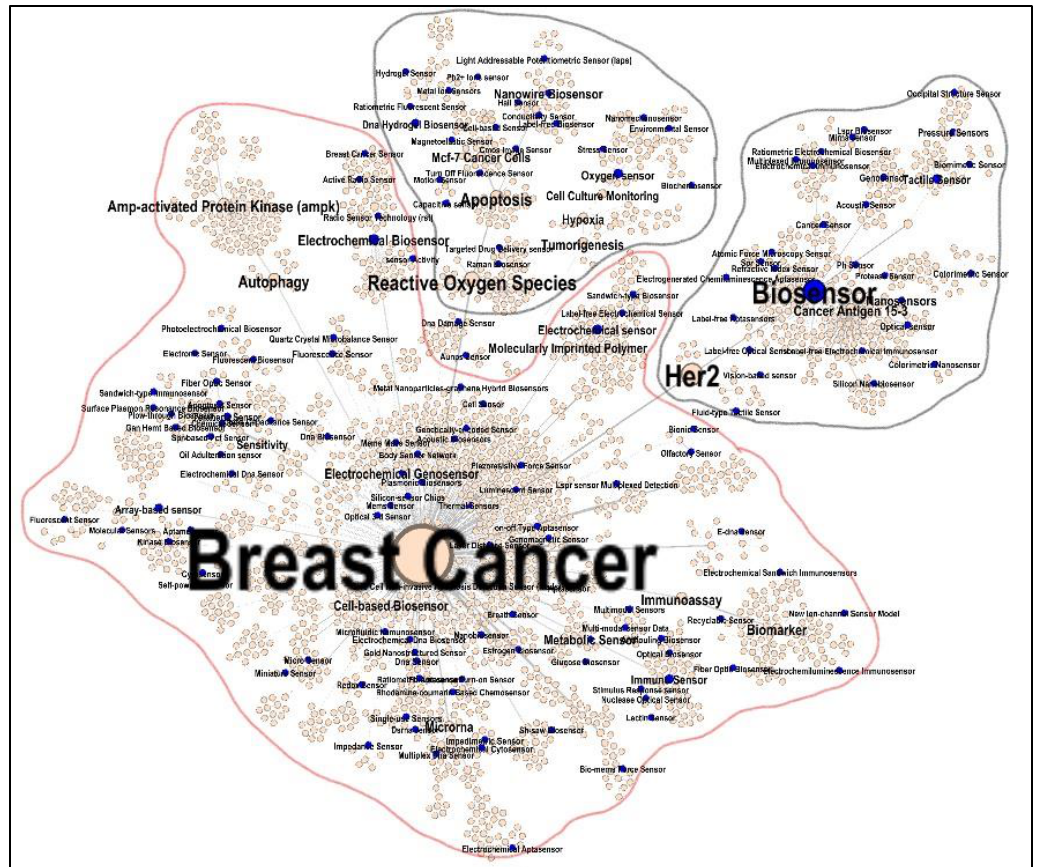
Figure 2. Co-word analysis map of breast